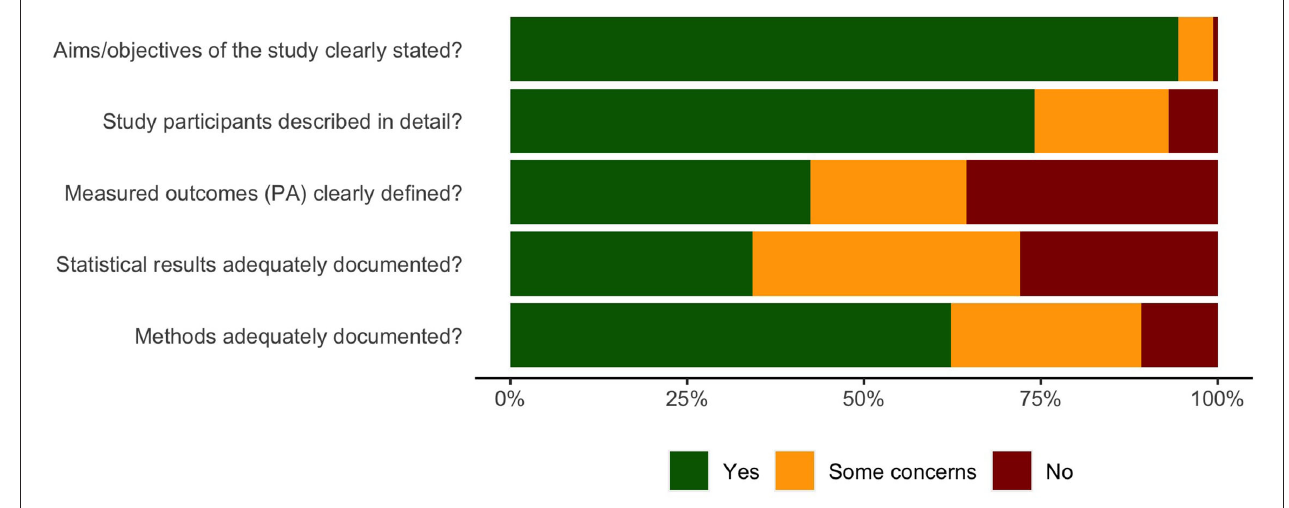
FIGURE 7 | Standardized assessment of methodological